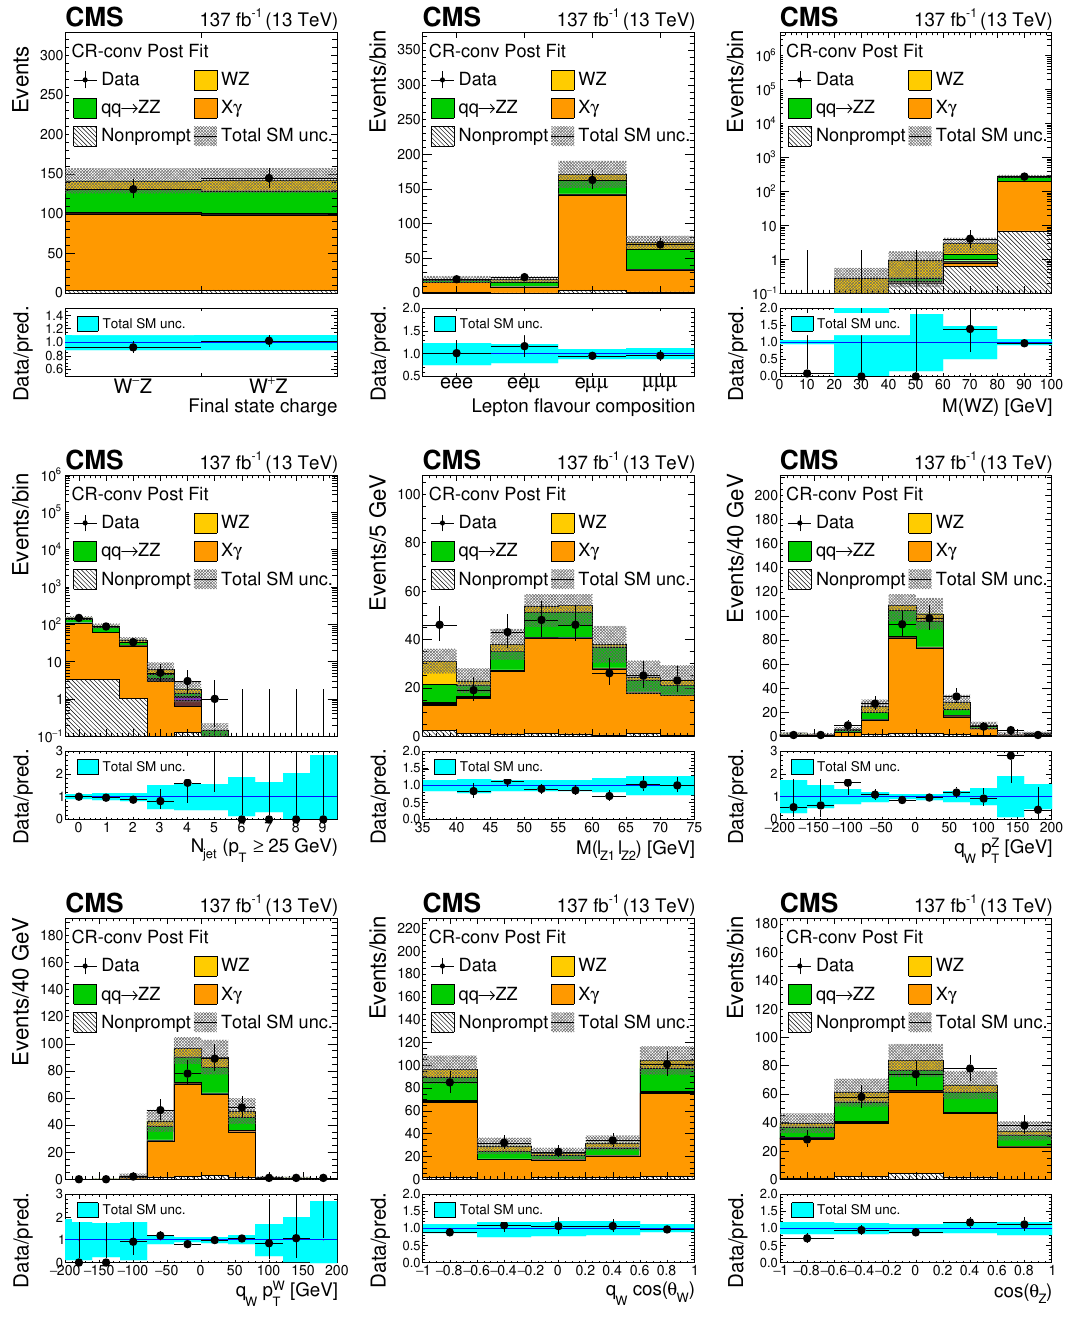
Figure 4 . As in figure 2, for the distribution of observables in the conversion control